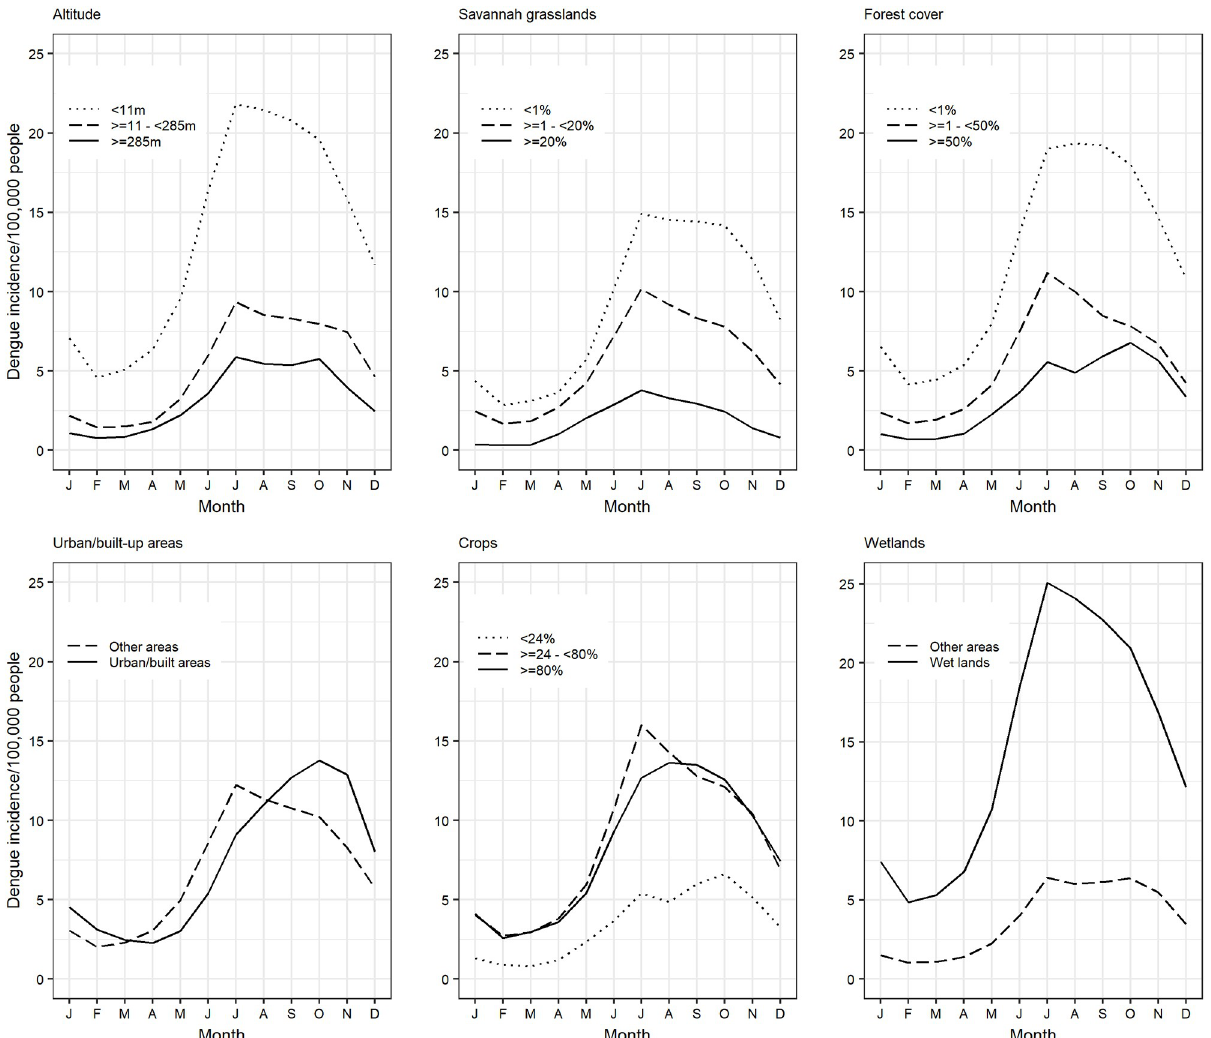
Fig 4. Trends in dengue incidence at various levels of environmental factors used in the study including altitude, area under savannah grassland, forests, urban development, crop farming and wetlands.